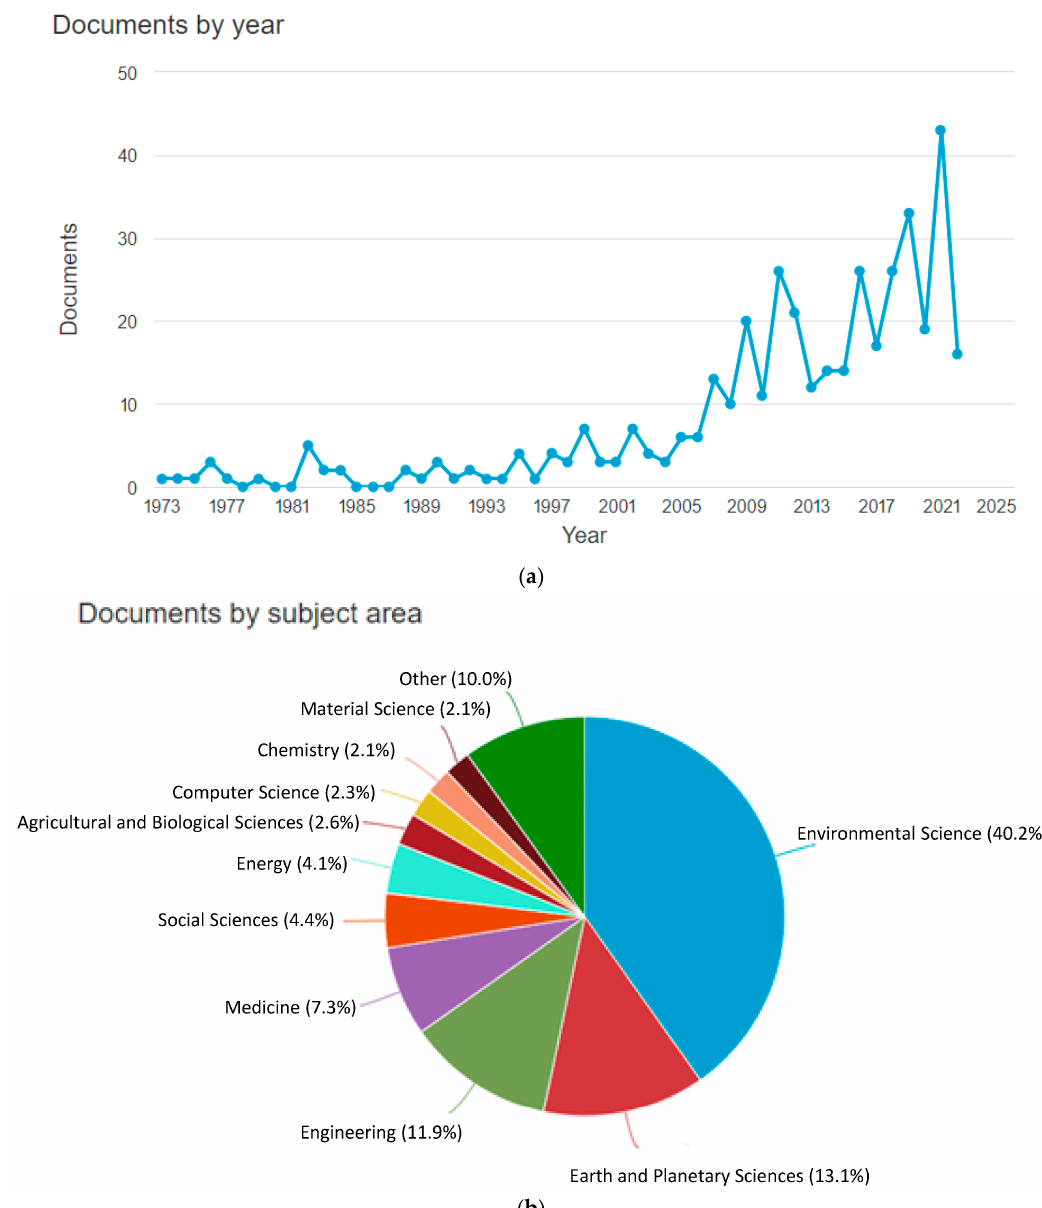
Figure 1. Analysis of the publications in the Web of Science database according to the keywords “construction site” and “dust pollution”: ( a ) the trend of publications over the years, ( b ) documents by disciplinary area (Scopus database).